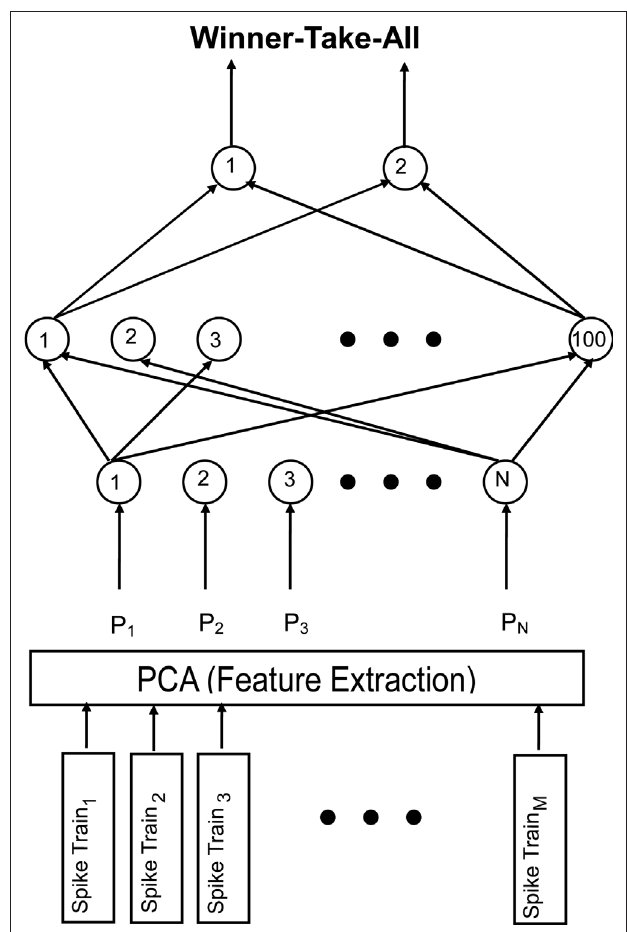
FIGURE 2 | Schematic of the multi-layer perceptron (MLP). For each neuron, the interspike intervals of M spike trains underwent principal- component analysis (PCA) to extract relevant features. For each spike train, the N components derived from the PCA were fed into the input layer of the MLP sequentially. The hidden layer of the network contained 100 nodes and the output layer contained 2 nodes. The network was a fully connected feedforward network. A winner-take-all approach applied to the output node: thus, the node with the highest activation determined the MLP’s